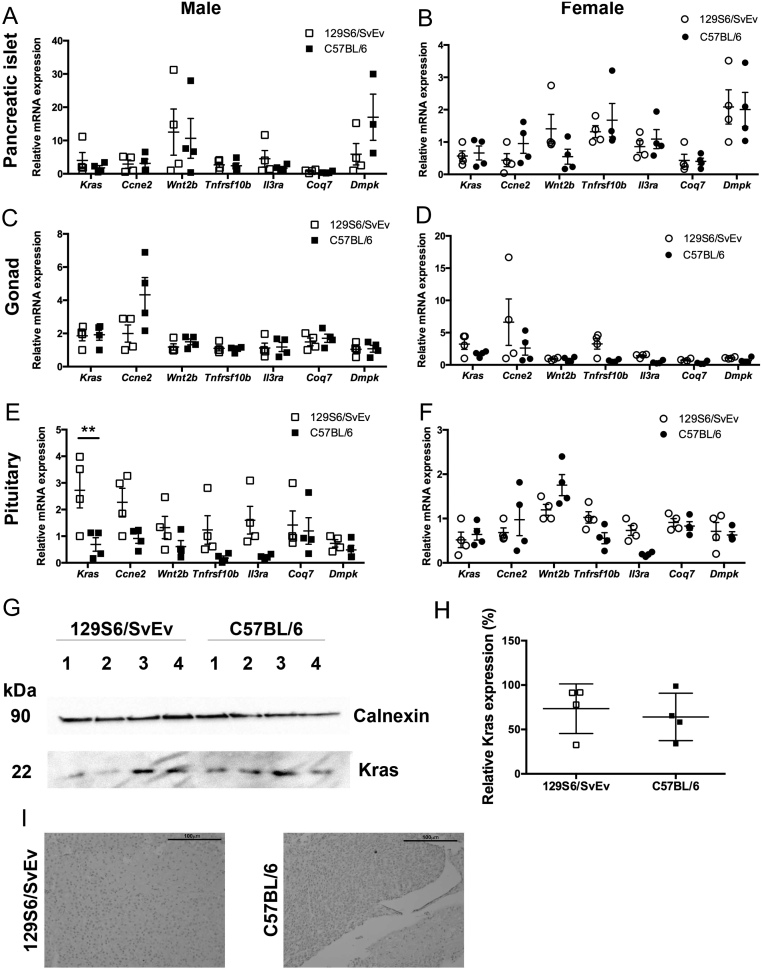
Expression of tumour-associated pathway genes with sequence variants observed in 129S6/SvEv and C57BL/6 mice. (A, B, C, D, E, and F) qRT-PCR was used to evaluate the expression of seven genes (Kras, Ccne2, Wnt2b, Tnfrsf10b, Il3ra, Coq7 and Dmpk) in pancreatic islet (A and B), gonadal (C and D) and pituitary (E and F) tissue harvested from male and female WT (Men1+/+) 129S6/SvEv and C57BL/6 mice. Data are represented as mean and s.e.m.; relative to one 126S6/SvEv mouse; n = 4 mice per group; **P < 0.005. (G) Western blot analysis of KRAS expression in male pituitary tissue harvested from Men1+/+ 129S6/SvEv and C57BL/6 mice; calnexin was used as a housekeeper. (H) KRAS expression from the Western blots was quantified using densitometry analysis. Data are represented as mean and s.e.m.; n = 4 mice per group. (I) Immunohistochemical analysis of KRAS expression in sections of male Men1+/+ 129S6/SvEv and C57BL/6 mice showing very low expression in PNET tissues. All images were taken using a ×20 objective, with the scale bar representing 100 μM.